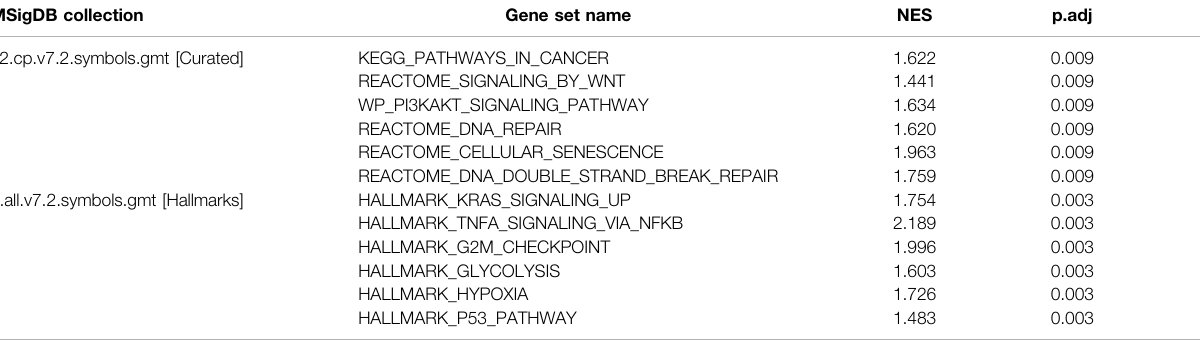
TABLE 4 | Gene sets enriched in positively correlated with H2BC12 mRNA expression phenotype high. MSigDB collection